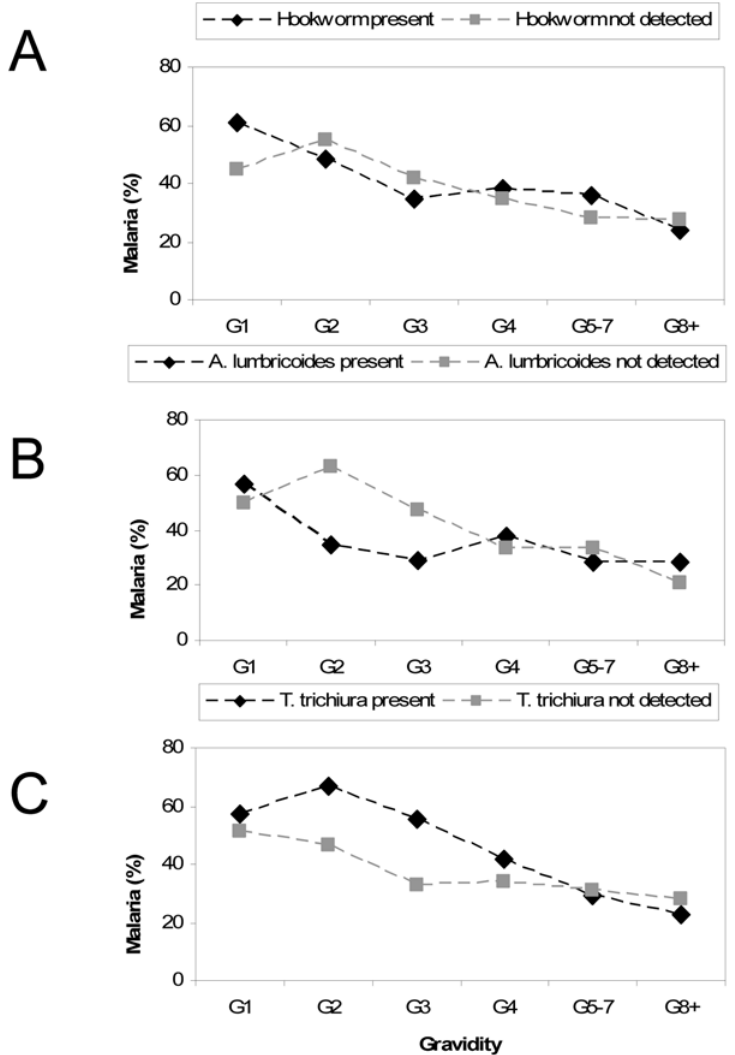
Figure 3. Prevalence of malaria by geohelminth infection and gravidity group among 390 pregnant women in Gem, July 2003.